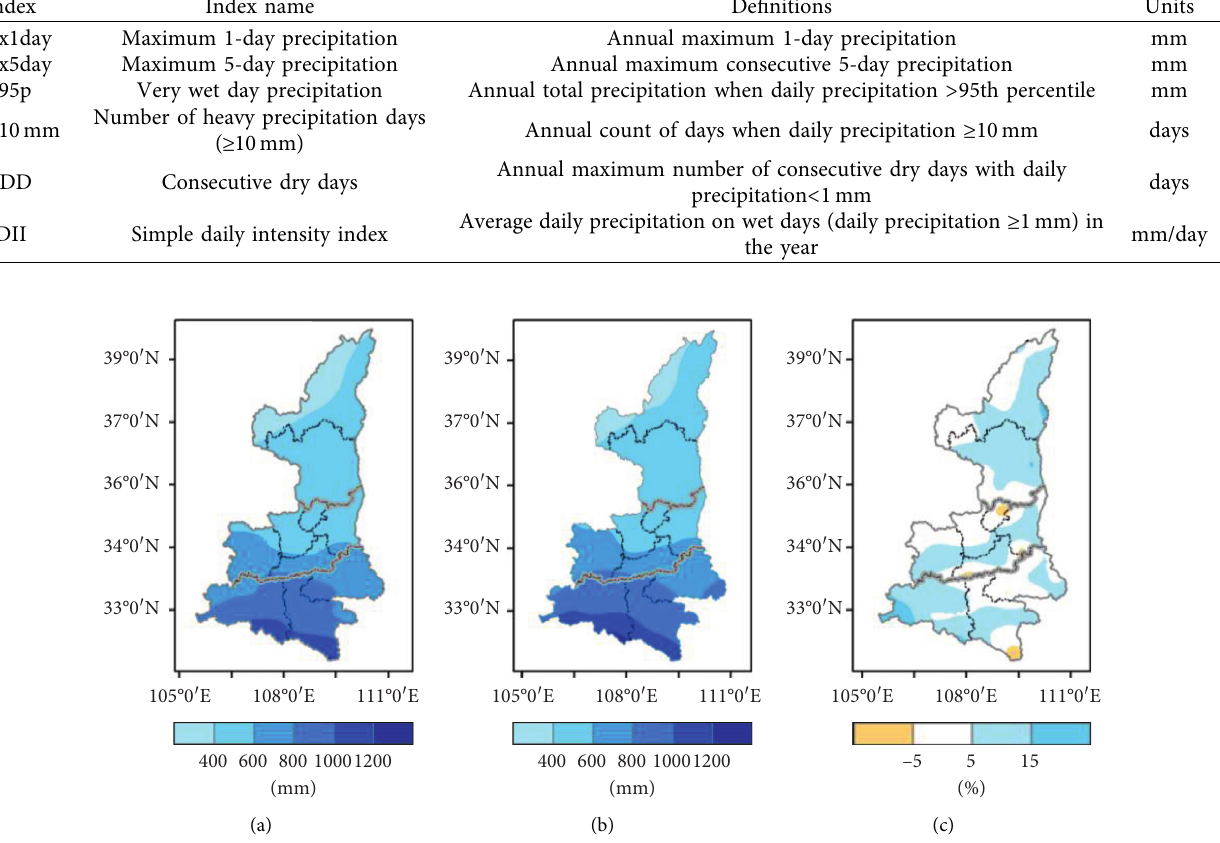
Figure 2: Spatial distribution of annual mean precipitation over Shaanxi Province during 1986–2005: (a) observed precipitation; (b) simulated precipitation; (c) difference between simulation and observation.